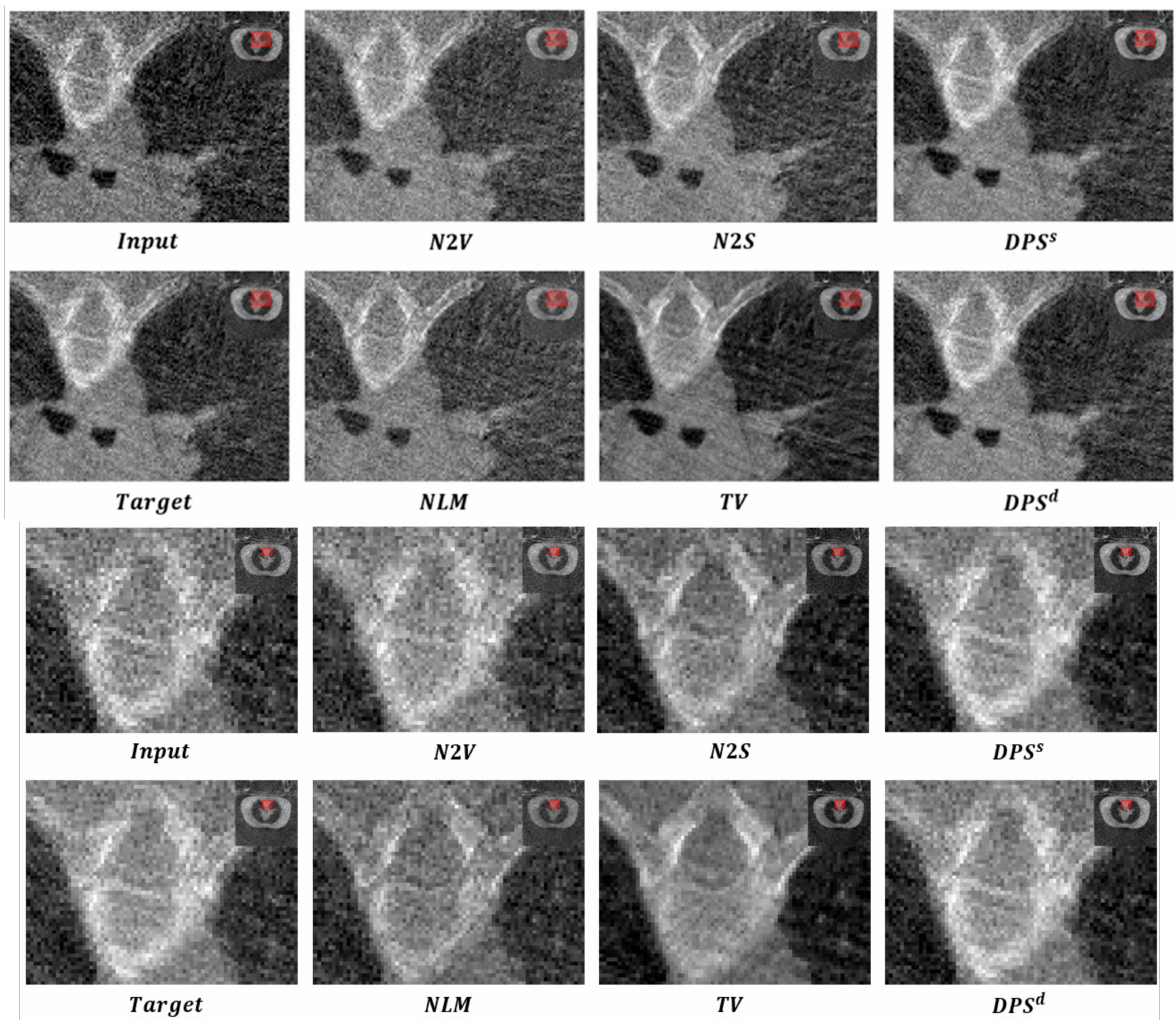
Figure 4. Two visual comparisons of various denoising methods from SPARE challenge dataset: (first and second rows) coarse architecture and (third and fourth rows) fine architecture. All images are in the axial view. Red boxes in the images indicate the expanded